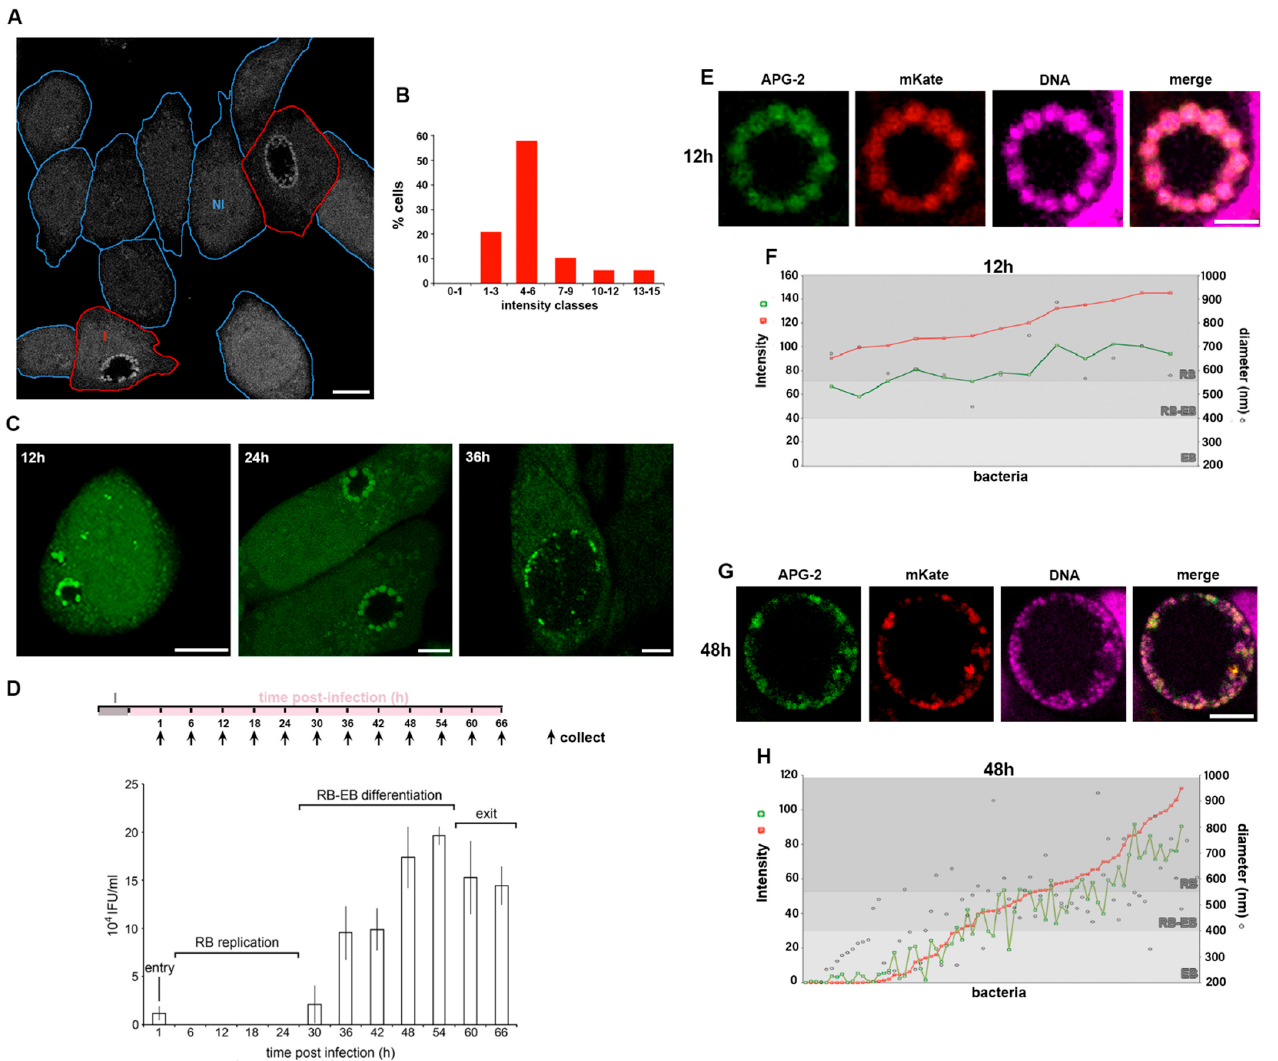
Figure 2. C. trachomatis RBs accumulate K + . HeLa cells were infected with C. trachomatis LGV2. ( A ) Infected cells were incubated with APG-2 24 hpi and a mixed population of infected and non-infected cells imaged. Cell edges are indicated in blue for non-infected cells (NI) and in red for infected cells (I). Scale bar: 10 µm. ( B ) Measured average cytoplasmic APG-2 intensity of non-infected cells were classified according the x -axis. ( C ) Infected cells at 12, 24 and 36 hours post infection (hpi) were incubated with APG-2 and imaged. Scale bar: 10 µm. ( D ) Upper panel: schematic of the experiment design. I: infection. Lower panel: Infectivity assay of cells collected at the indicated time on the x -axis corresponding to the collection time on the upper panel. The y -axis shows the inclusion forming unit per mL (IFU/mL). The different phases of infection corresponding to the infectivity assay are indicated. Error bars: standard deviation. ( E – H ) cells were infected with C. trachomatis LGV2 as in ( A ) to ( D ), but bacteria were transformed with pASK-GFP-L2 allowing the expression of mKate (red) only when the bacteria are in the RB form. Cells were incubated with APG-2 at the indicated time point (( E , F ) 12 hpi; ( G , H ) 48 hpi) and imaged. Image analyses were performed as described (Experimental Procedures and Figure S1B) allowing the measurement of the bacterial diameter, the intensity of APG-2 (green) and mKate (red) for each individual bacteria (( F ) and ( H ), grey level reflecting different type form of the bacteria).